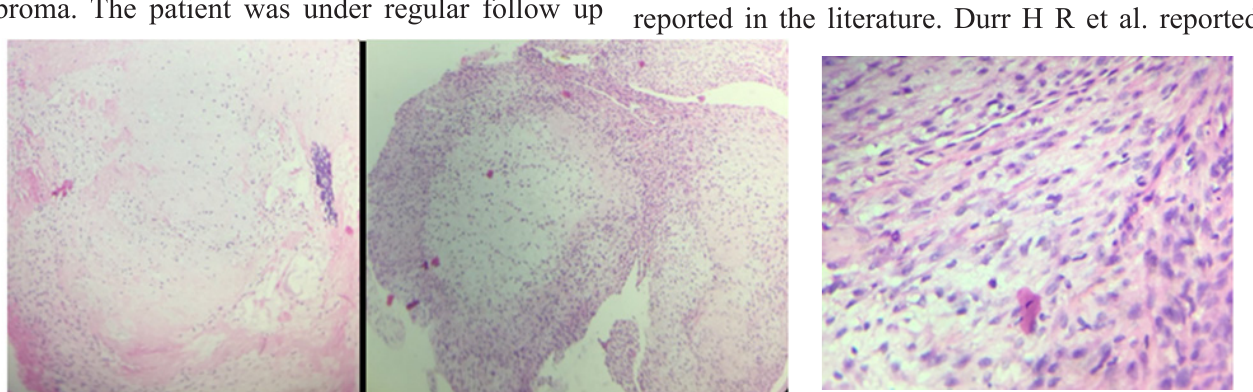
Fig 5: Histopathological images: mass composed of hypocellular lobules of poorly formed hyaline cartilage composed of chondroblasts. Periphery is more cellular. Myxoid area: stellate cells with long process. Areas of calcification seen.